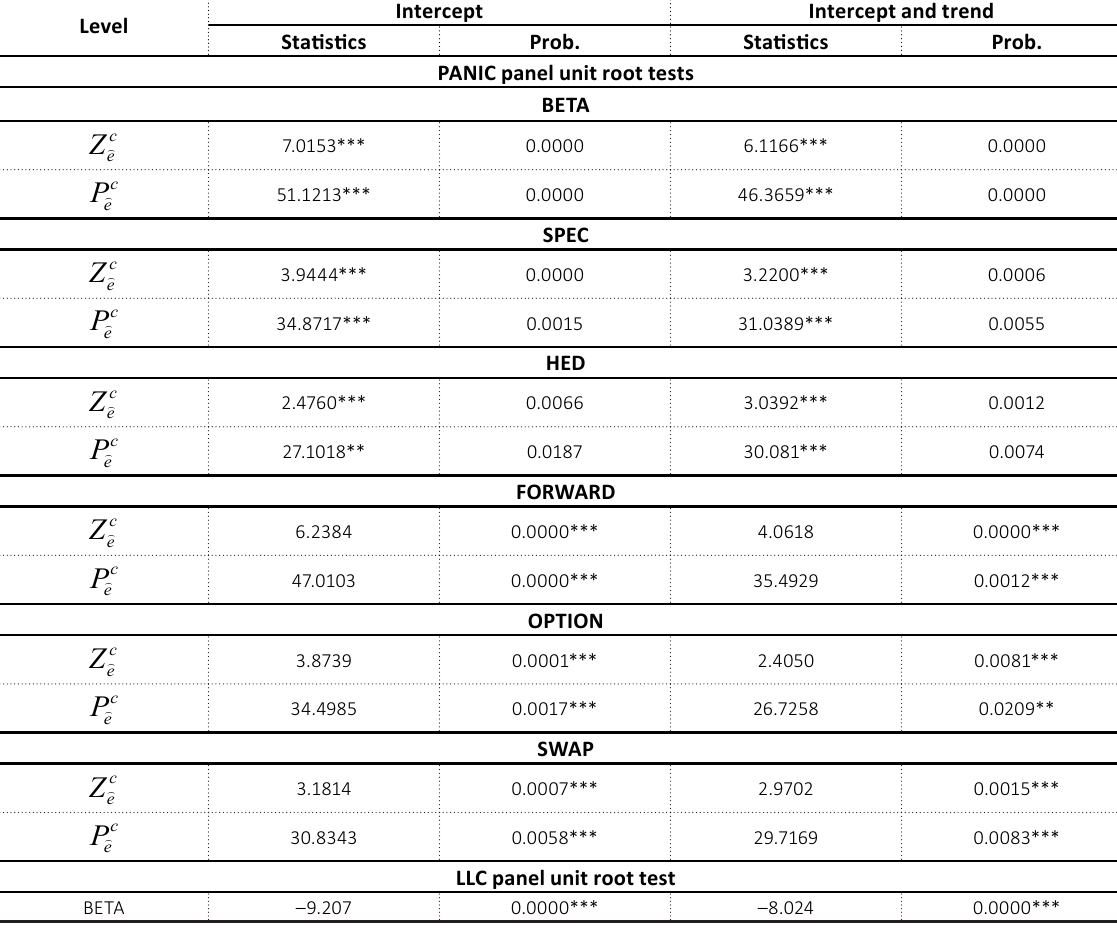
Table 7. The results of PANIC and LLC panel unit root